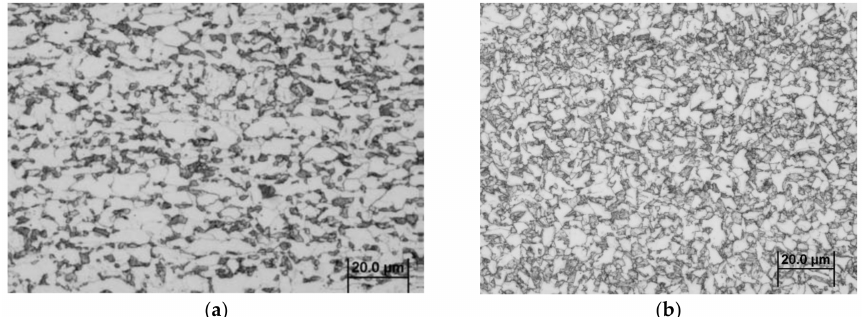
Figure 5. The microstructure of material B after annealing: ( a ) DPB 750 ; ( b ) DPB 820 .